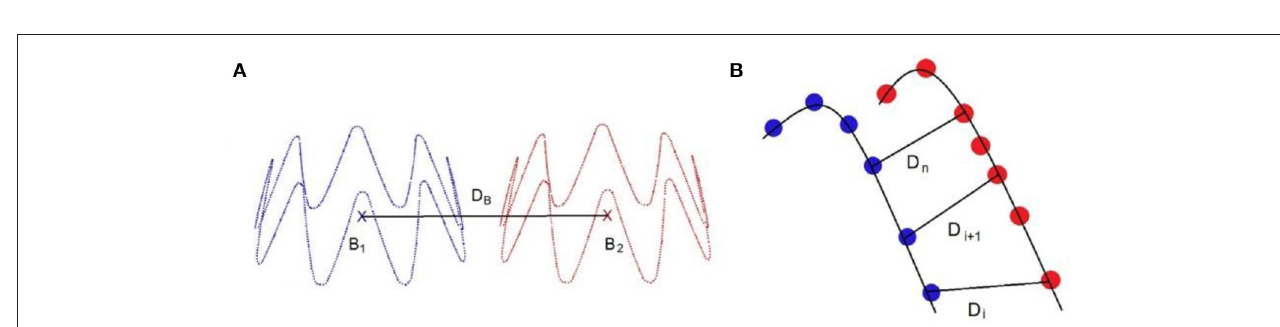
FIGURE 5 | Distance measurement: D B is the distance between the stents point clouds barycenters (A) , D PC is the average distance between the closest neighbors of the point clouds of the target stent and the simulated sten, such as D PC =